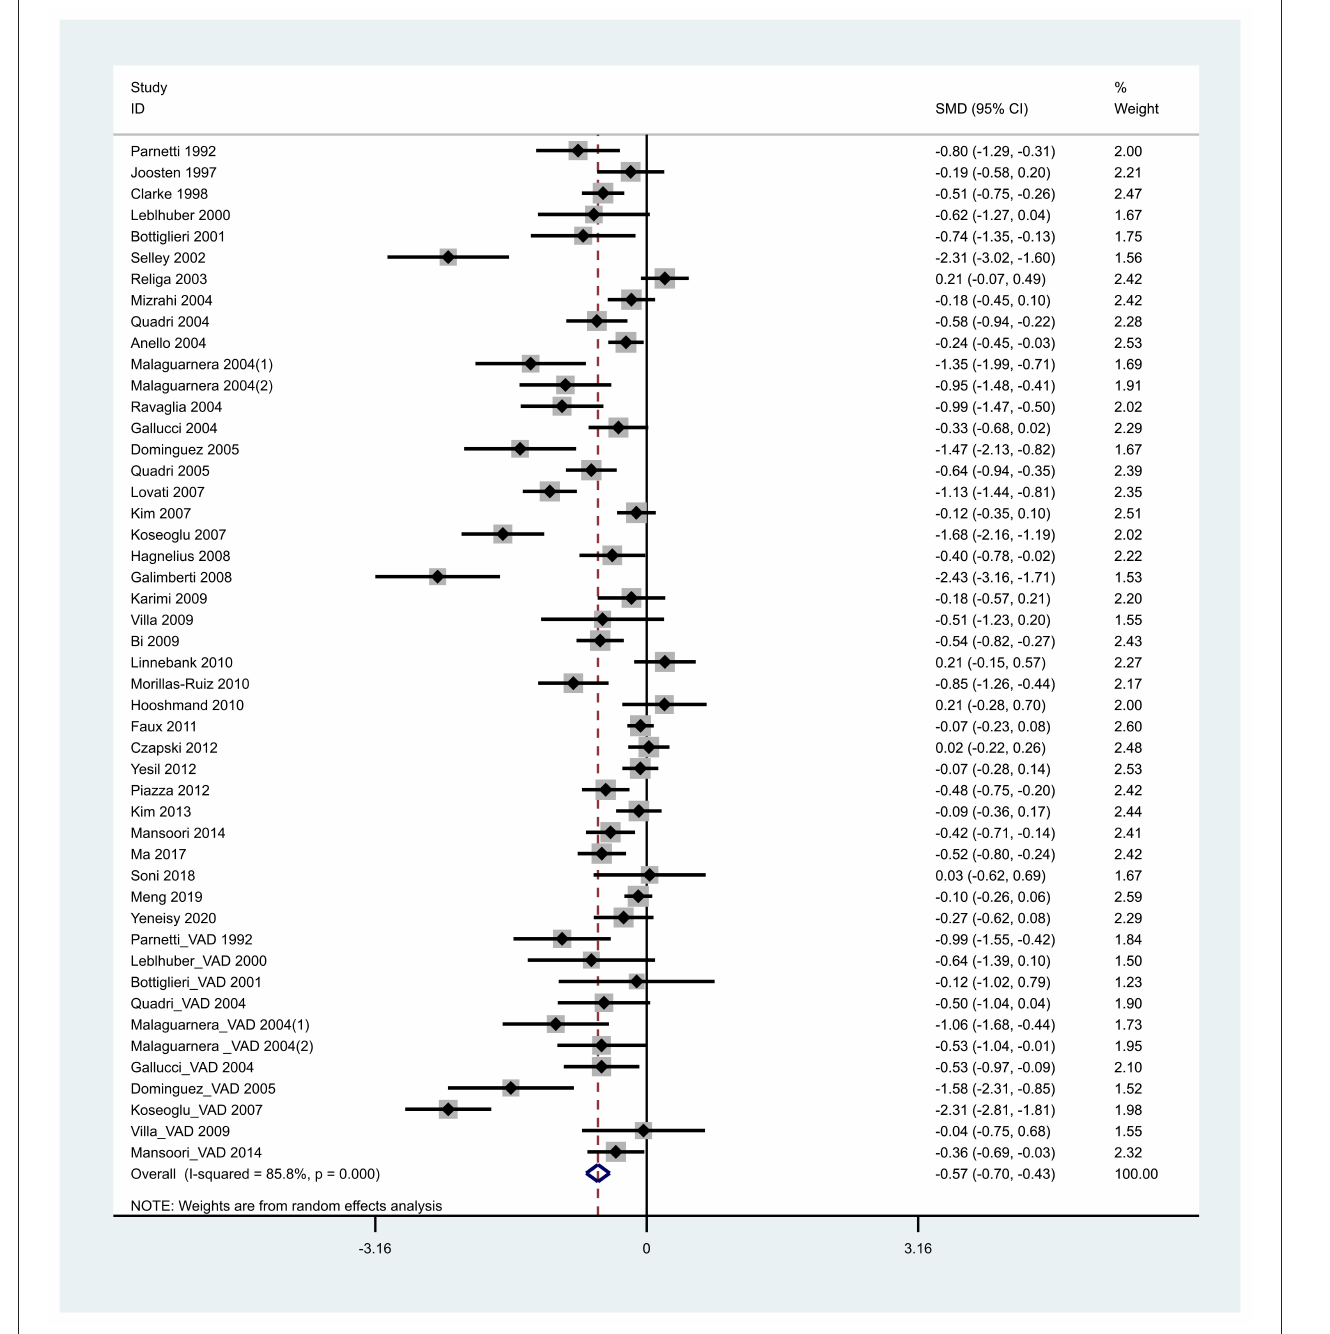
FIGURE 3 | Forest plot of standard mean difference (SMD) and 95% confidence interval (95%CI) in dementia and control group for folic acid.